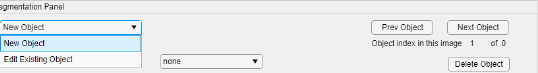
Figure 4. Example of object visualization and segmentation.